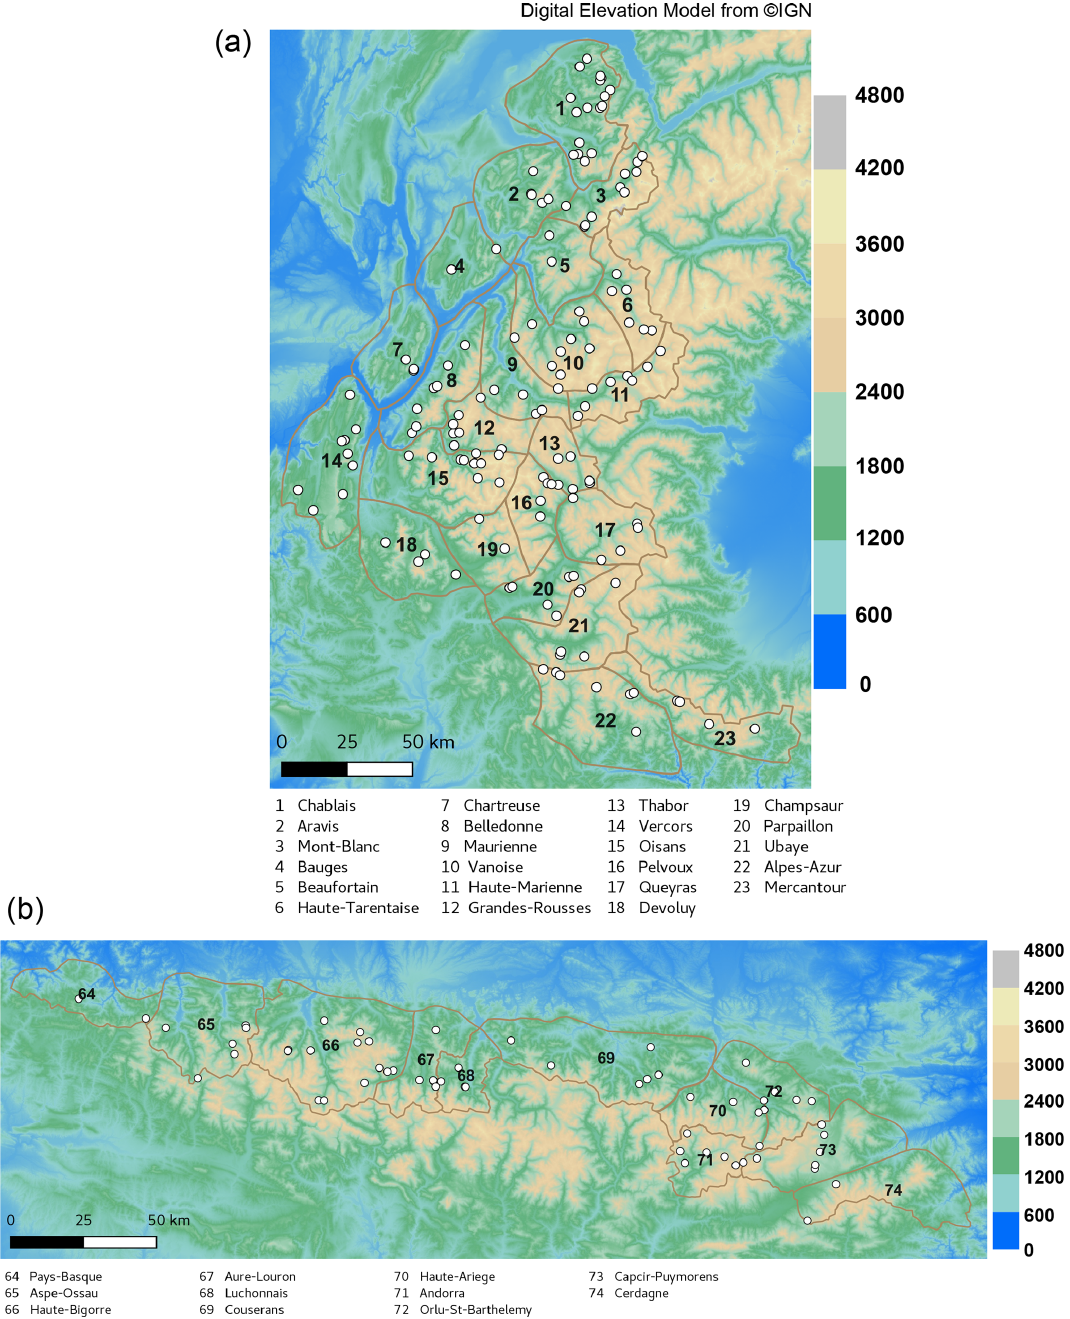
Figure 1. Map of massifs in the French Alps (a) and Pyrenees (b) , with altitude in metres and the observation stations represented as white